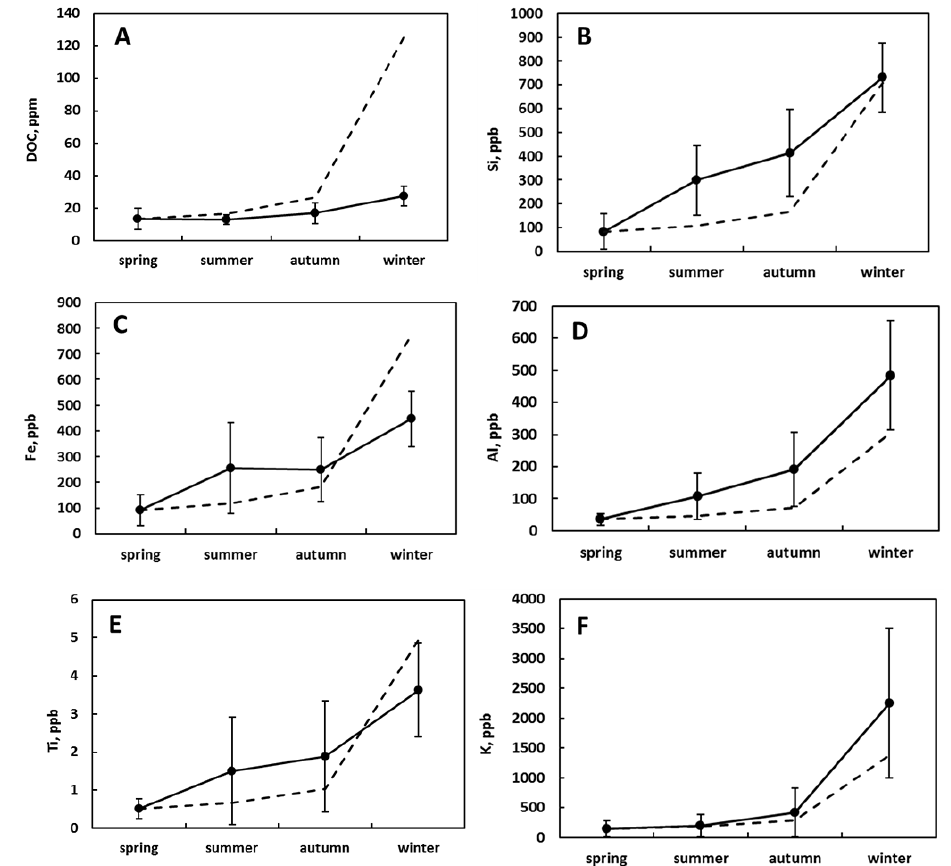
Figure 7. Size-averaged concentrations of DOC (a) , Si (b) , Fe (c) , Al (d) , Ti (e) , K (f) , Zn (g) , Cr (h) , Ni (i) , Cu (j) , Cd (k) and Pb (l) during different seasons. The points are the average and the error bars are the standard deviation. Only the medium and large lakes ( > 100m 2 surface area) were used for this estimation. The dotted line represents conservative behavior for a hypothetical lake of 75cm depth in summer, 20cm flooding in spring, surface 20cm ice formation in October, and almost full freezing (10cm bottom water left) in